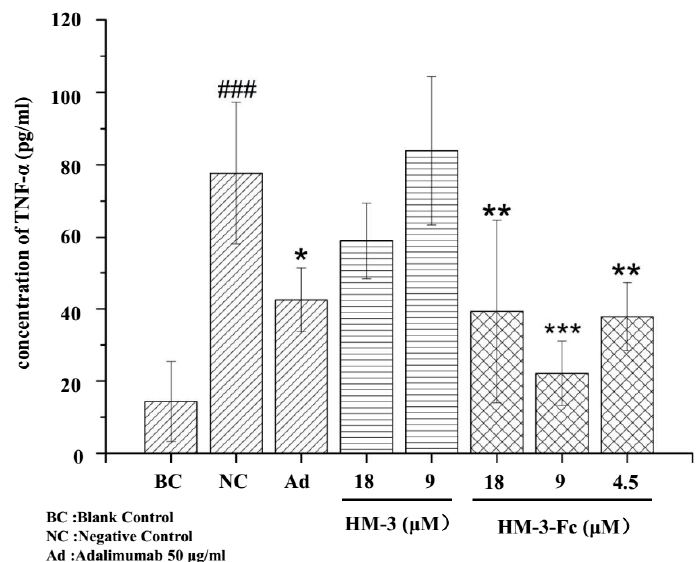
Figure 5. The effects of HM-3 and HM-3-Fc on the expression of TNF- α by U937 macrophages. Cells without LPS induction were used as a normal control. The other cells were inducted with LPS and the cells without drug treatment were used as a negative control. The other cells were incubated with HM-3 or HM-3-Fc at indicated concentrations, with 50 μ g/mL Adalimumab as a positive control drug. Results were presented as mean ± SD ( n = 3). ### p < 0.001 vs. Blank Control. * p < 0.05, ** p < 0.01 and *** p < 0.001 vs. Negative Control.